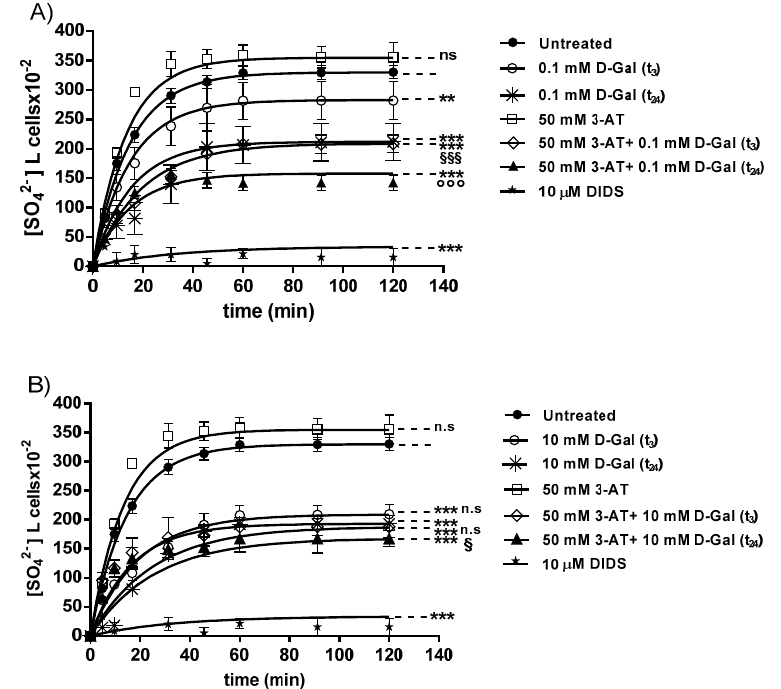
Figure 2. ( A ) Time course of SO 42 − uptake in untreated (control) and in 0.1 mM D -Gal (t 3 and t 24 )-treated erythrocytes. ns, not significant versus control, *** p < 0.001, ** , p < 0.01 versus control, §§§ , p < 0.001 versus 0.1 mM D -Gal (t 3 ) and, °°° , p < 0.001 versus 0.1 mM D -Gal (t 24 ), as determined by one way ANOVA followed by Bonferroni’s post hoc test (n = 6). (B ) Time course of SO 42 − uptake in untreated (control) and in 10 mM D -Gal (t 3 and t 24 )-treated erythrocytes. ns, not significant versus control, *** , p < 0.001 versus control and § , p < 0.05 versus 50 mM 3-AT + 10 mM D -Gal (t 3 ), as determined by one way ANOVA followed by Bonferroni’s post hoc test (n = 6).